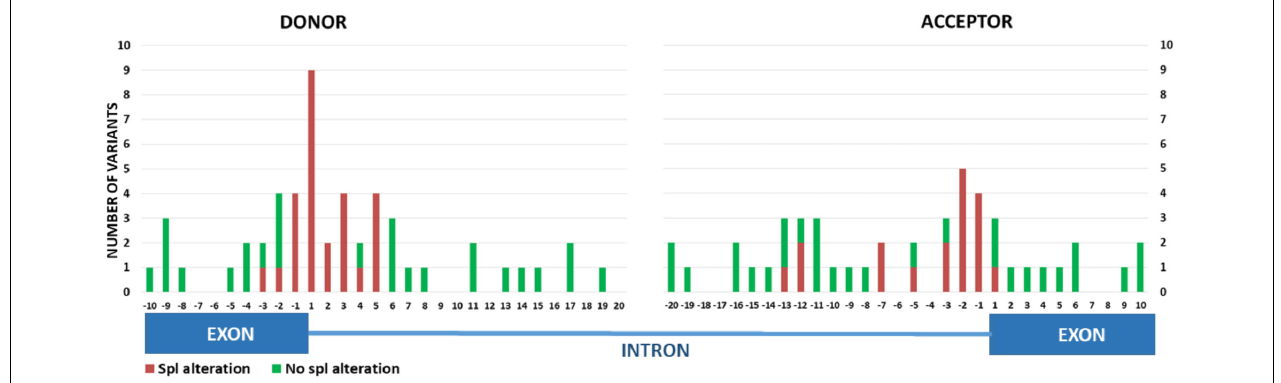
FIGURE 1 | In vitro RNA results collected in the discovery set. Experimental data are displayed according to variation location. Positive splicing alterations include: exon skipping, use of a new or cryptic splice site or an altered-alternative transcript profile. Negative splicing alteration: in vitro RNA result was exactly the same as that obtained in control samples. Spl,